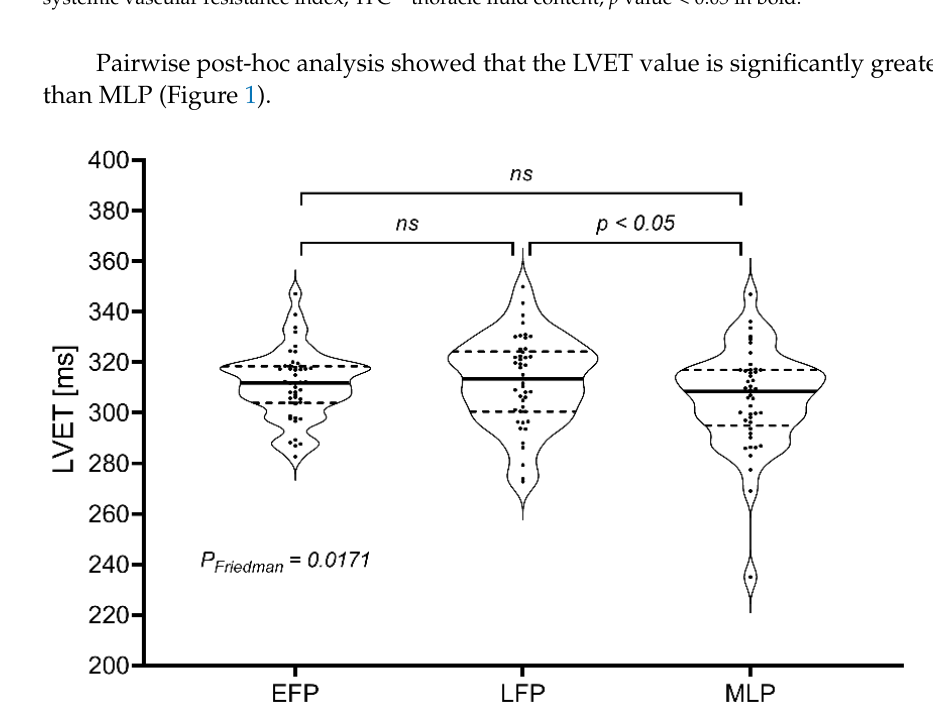
Table 2. Haemodynamic profile and indices of body water amount in healthy women during con- secutive phases of the same physiological menstrual cycle.